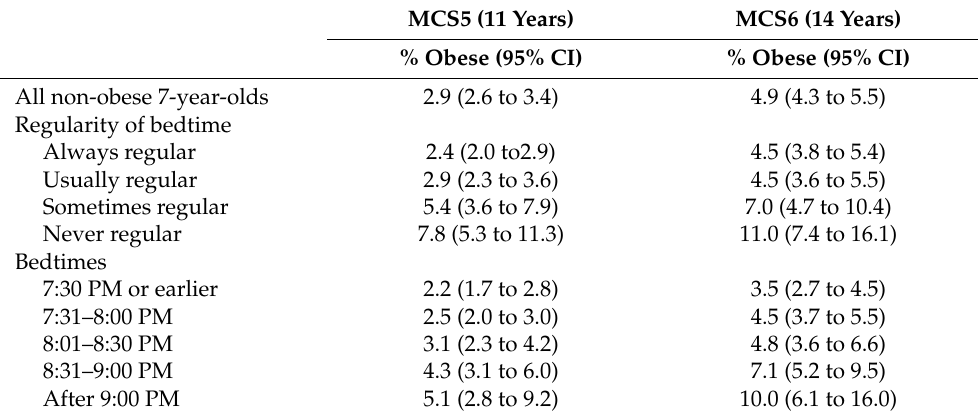
Table A2. Obesity incidence at 11 and 14 years by weekday bedtime schedules at 7